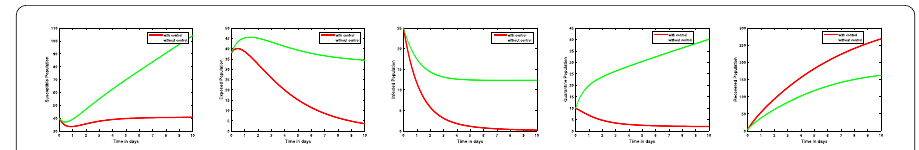
Figure 5 Profiles for behavior of each state variable for the fractional model with and without control